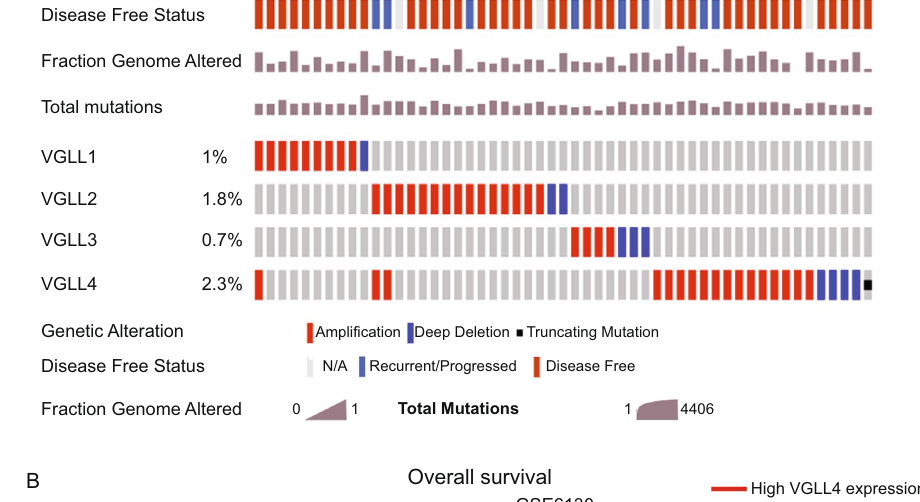
our observations, we used shRNA targeting VGLL4 to efficiently knockdown endogenous VGLL4 in T47D, a breast cancer cell line that expresses high levels of VGLL4. Inhibition of VGLL4 markedly enhanced cell prolifer- ation and cell migration (Fig. 3A,B). VGLL4 Suppresses Breast Cancer Progression in a Xenograft Mouse Model. To test whether VGLL4 modulates tumorigenesis in vivo , we subcutaneously injected control or VGLL4-overexpressing CAL- 51 cells into severe combined immunodeficiency (SCID) mice. Both tumor growth rate and tumor size were dramatically reduced for VGLL4-overexpressing cells compared with control cells (Fig. 3C,D). Morphologically,